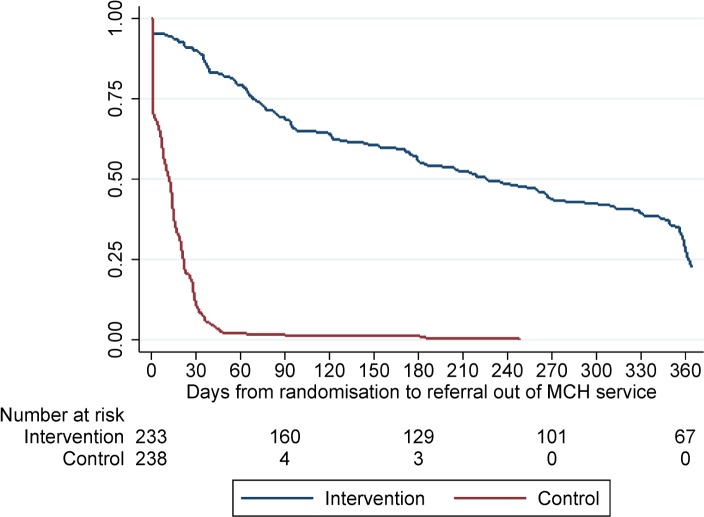
Time to referral out of the maternal and infant health (MCH) service for women in the intervention and control arms.Log-rank test, p < 0.001.